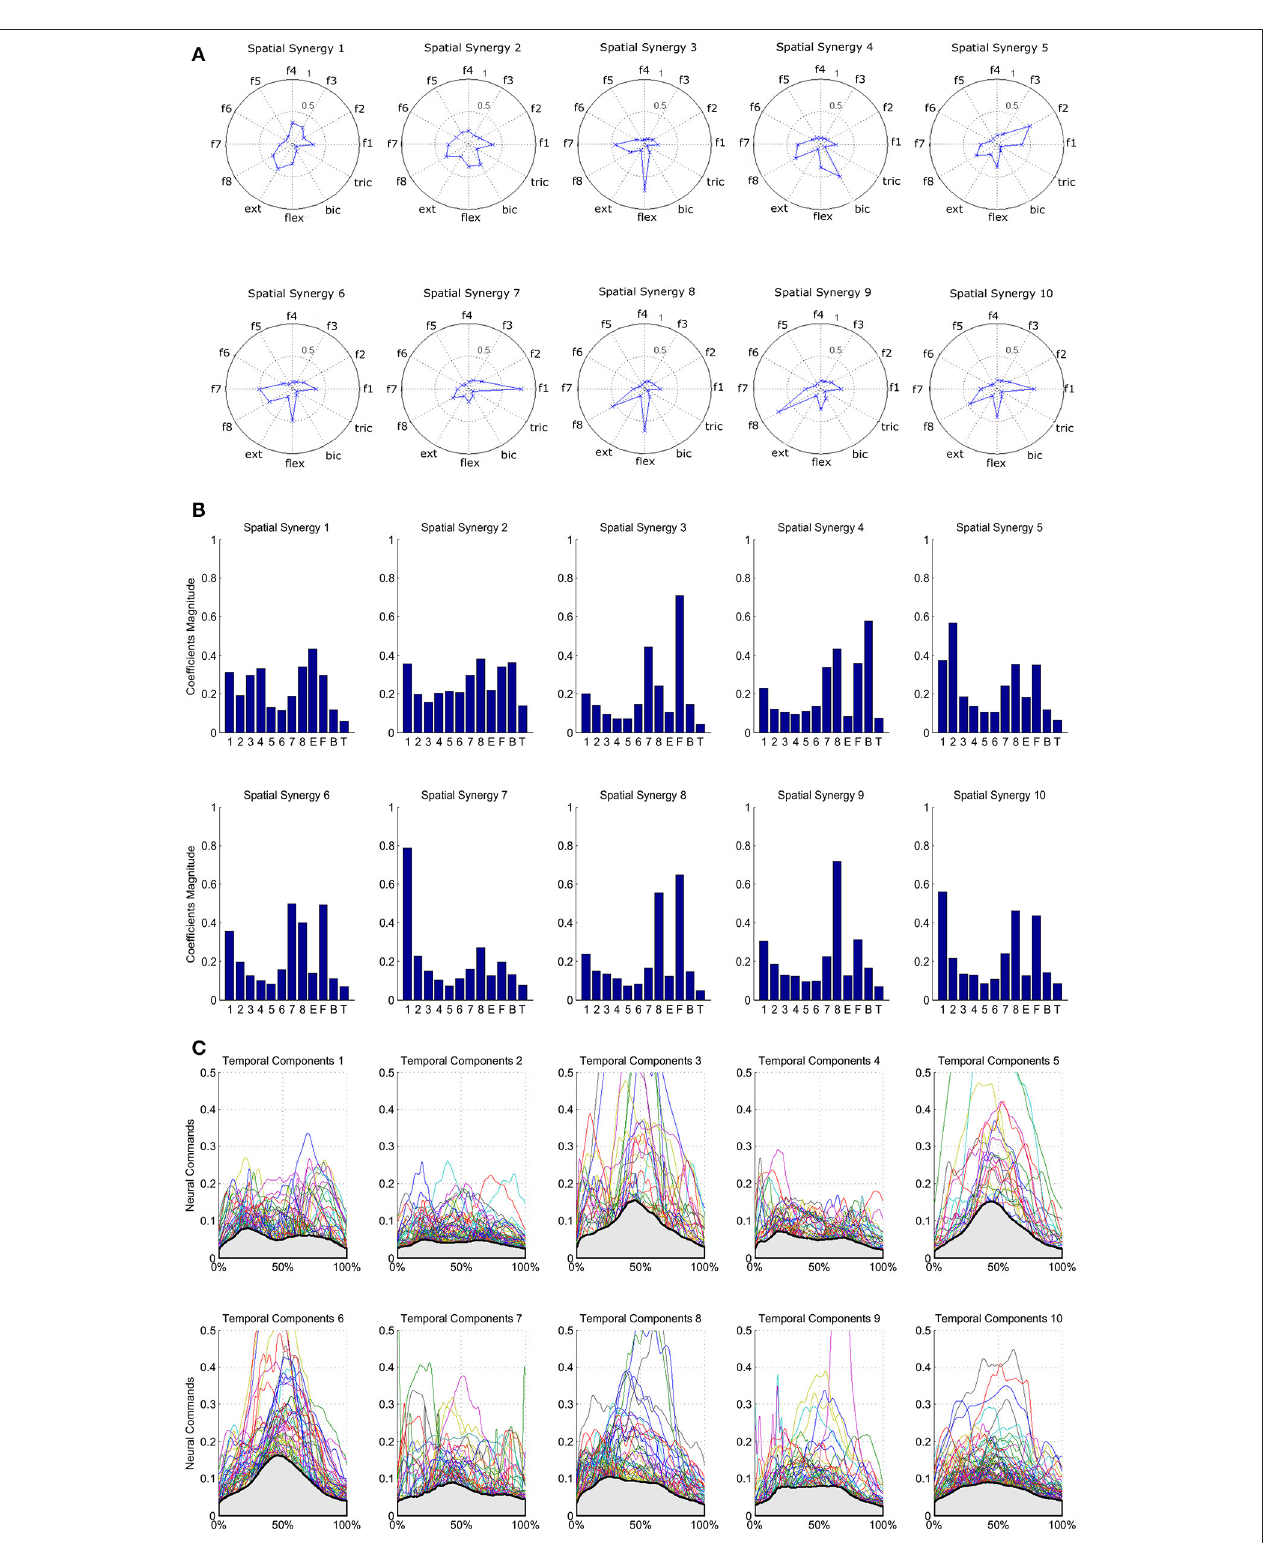
FIGURE 7 | Summary of the extracted spatial synergies and mean temporal components associated with each spatial synergy. Spatial synergies are represented in a polar plot (A) and with histograms (B) . Temporal components are depicted in (C) , and mean temporal components are shown in light gray.